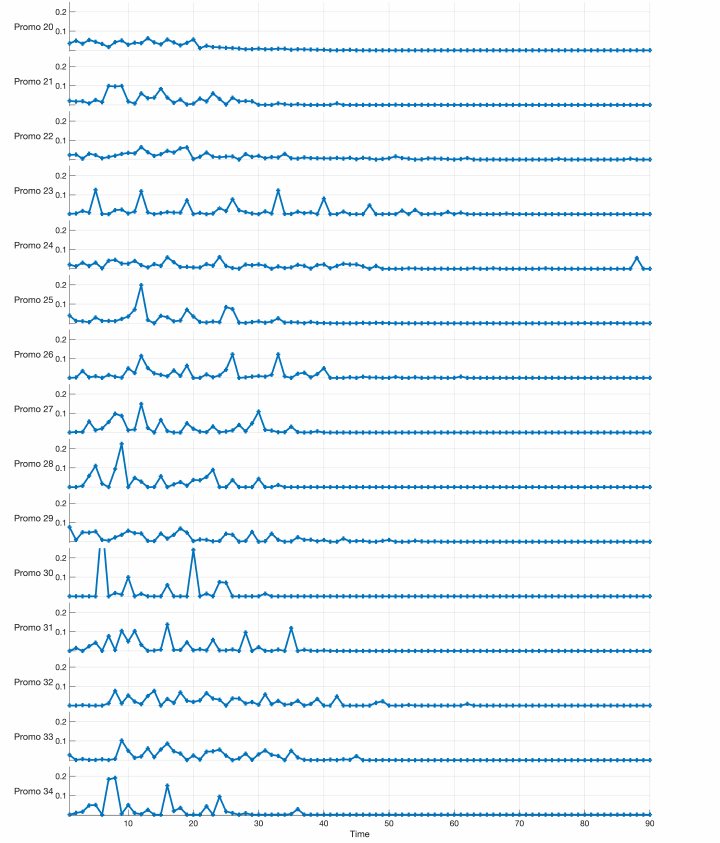
Figure 1. Examples of time series related to the percentage sales enhancements over a horizon of 90 days (horizontal axis) of 15 promotional campaigns. The percentage sales enhancements (vertical axis) of the promotional demand is referred the non-promotional baseline